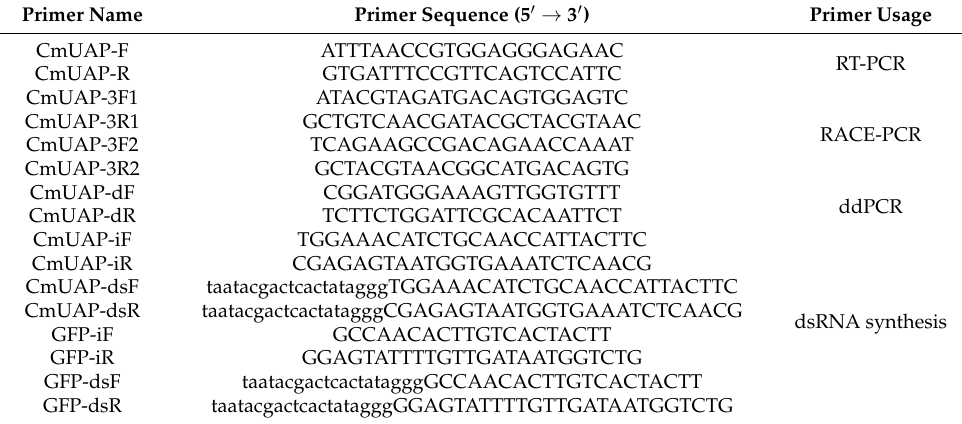
Table 1. Primers used for cloning and expression analysis of CmUAP from C.